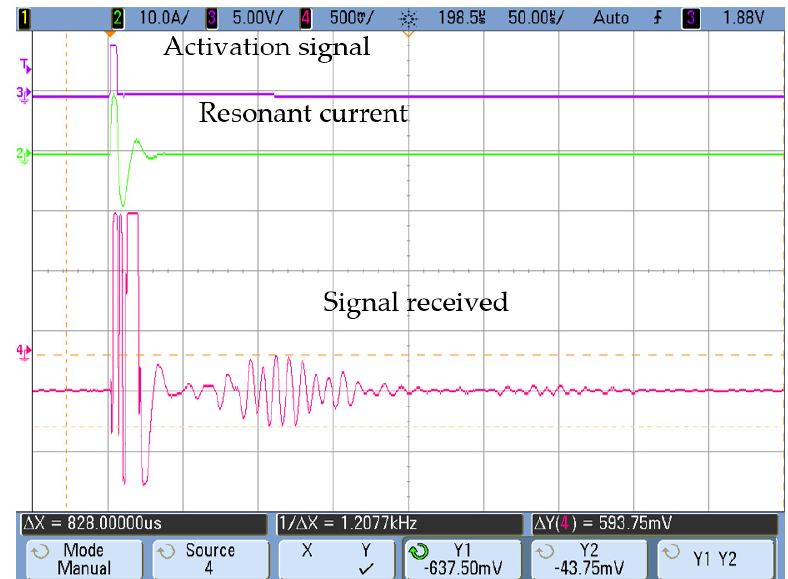
Figure 15. Signal received with a total silicone blockage (Figure 13a) at position A.